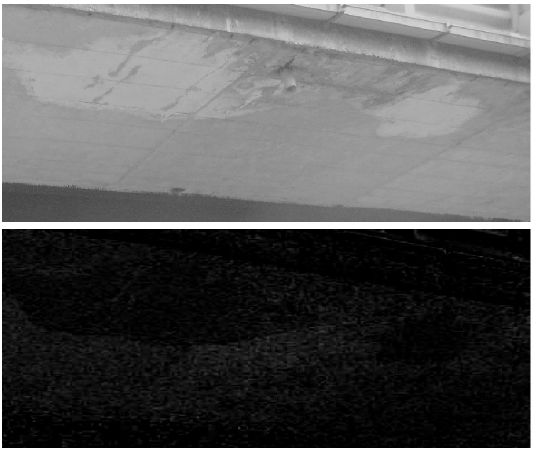
Figure 3: L ∗ (top) and a ∗ (bottom) channels for the image in Fig. 1. Brighter pixels are associated to higher values of the con- sidered variables.